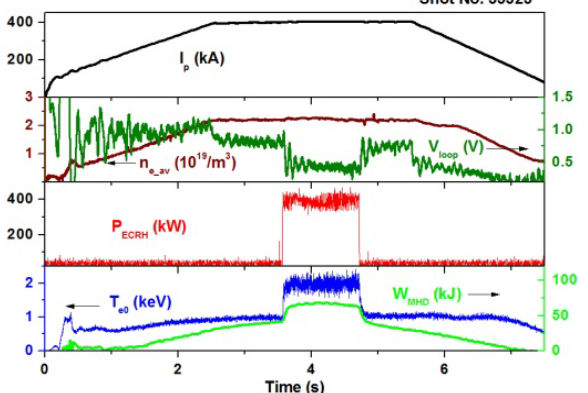
Fig. 11. Time evolution ofI p , n e_av , V loop , ECRH power, T e0 , and W MHD with ECRH.